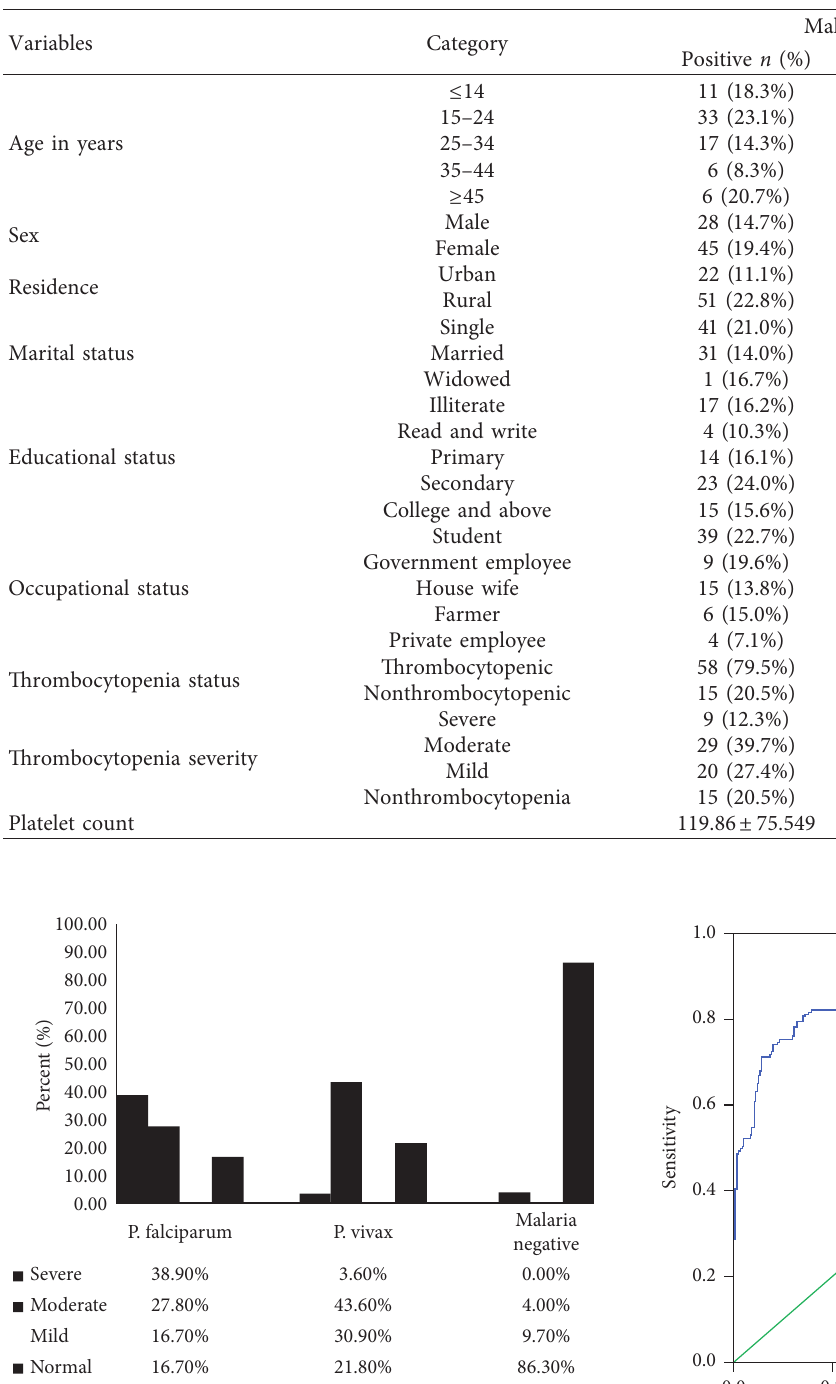
Table 2: Characteristics of acute febrile patients with and without malaria